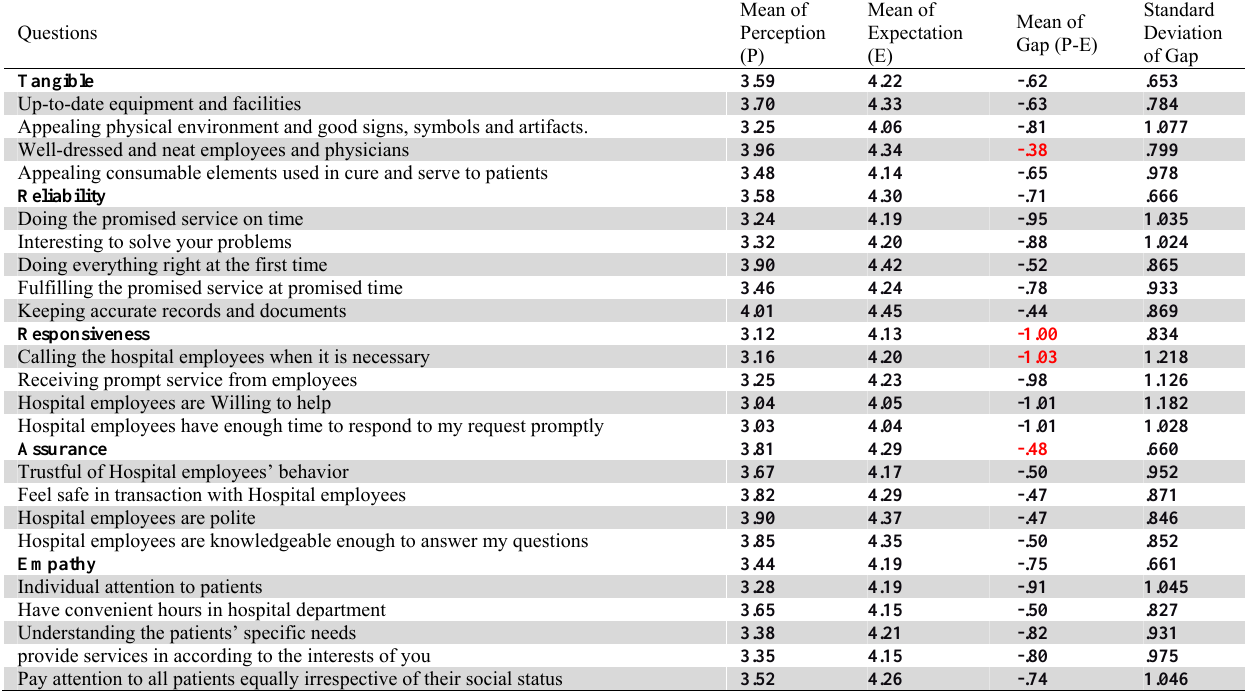
Gap Analysis of Hospital service quality Dimensions